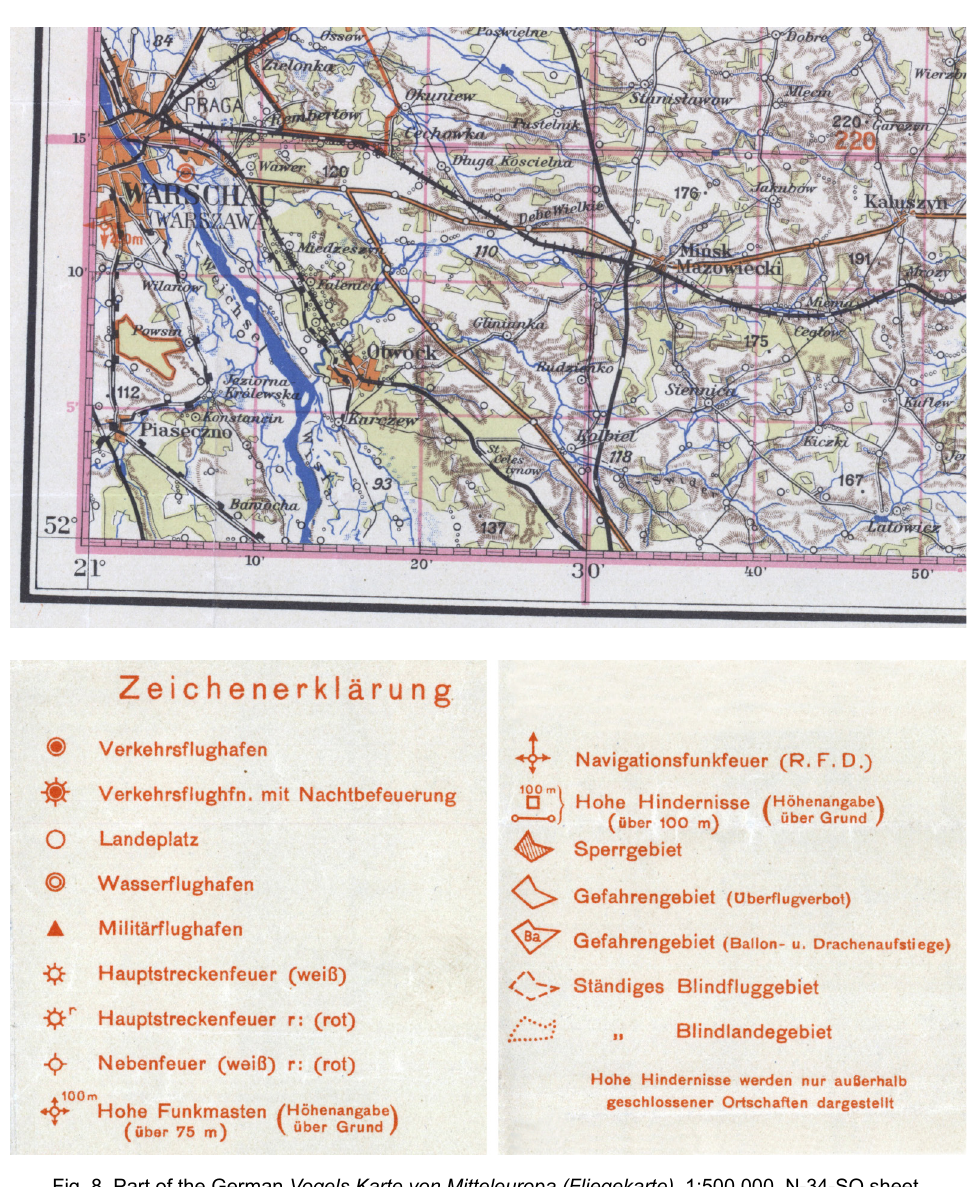
Fig. 8. Part of the German Vogels Karte von Mitteleuropa (Fliegekarte), 1:500,000, N-34-SO